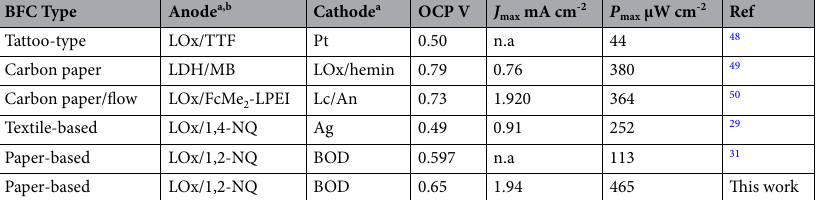
Table 1. Performance of lactate BFCs. n.a.: not available; a enzymes: BOD: bilirubin oxidase; Lc: laccase; LDH: lactate dehydrogenase; LOx: lactate oxidase; b mediators: 1,2-NQ: 1,2-naphthoquinone; 1,4-NQ: 1,4-naphthoquinone; An: anthracene; FcMe2-LPEI: dimethylferrocene-modified linear polyethyleneimine; MB: methylene blue; TTF: